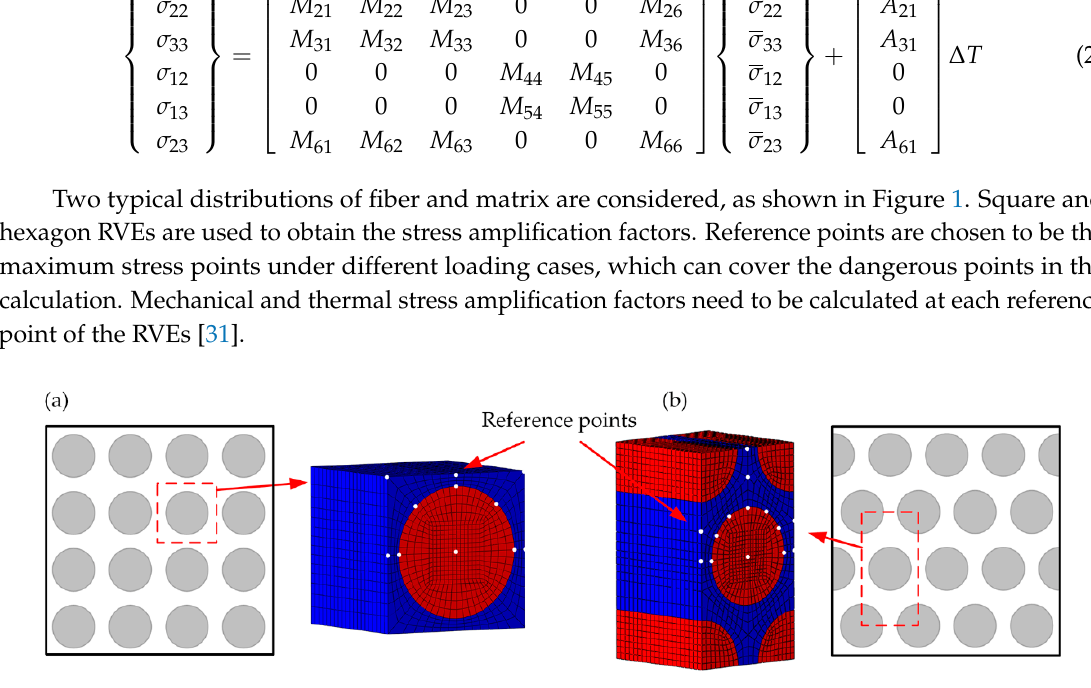
Figure 1. Representative volume elements: ( a ) Square RVE; ( b ) Hexagon RVE.